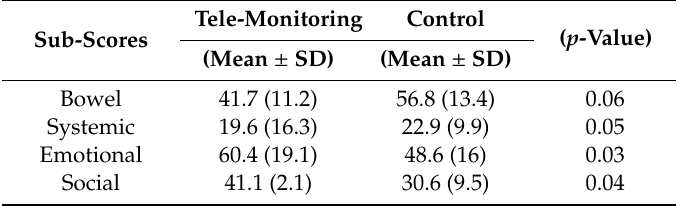
Table 5. Total and partial IBDQ32 scores for the tele-monitoring vs. control